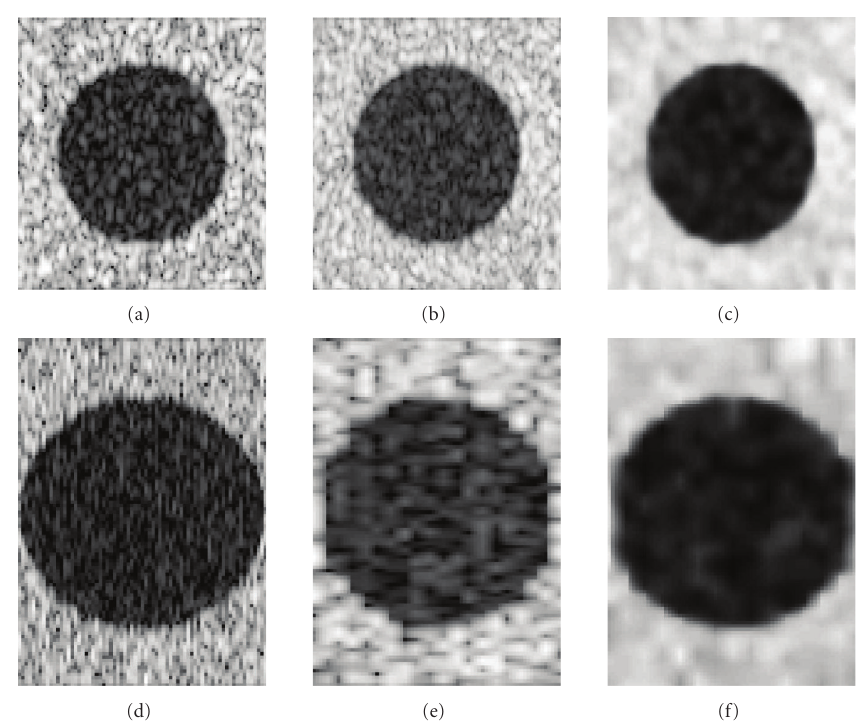
Figure 4: Reconstruction result for a spherical target from synthetic ultrasound data: (a) a slice of simulation data, (b)-(c) a slice of re- construction result from bilinear and MMSE methods, (d) sagittal view of simulation data, (e)-(f) sagittal view from bilinear and MMSE reconstruction